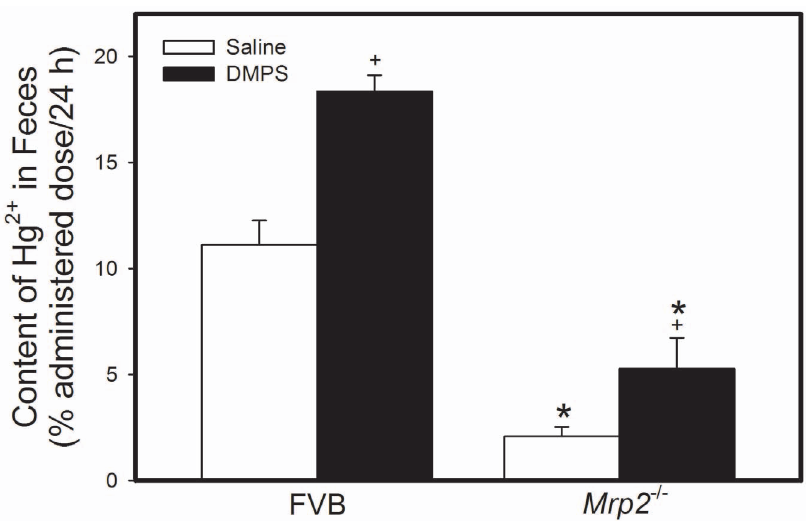
Figure 5. Content of Mercury in Feces of Mrp2 2 / 2 and FVB Mice. Mrp2 2 / 2 and FVB mice were injected intraperitoneally with a dose of 0.5 m mol ? kg 2 1 ? 8 mL 2 1 . Feces were collected 24 h and 48 h after injection with HgCl 2 . Data represent mean 6 SE of feces collected from four mice. *, significantly different from mean of corresponding FVB mice (p , 0.05). + , significantly different from mean of mice from same strain treated with saline (p , 0.05).